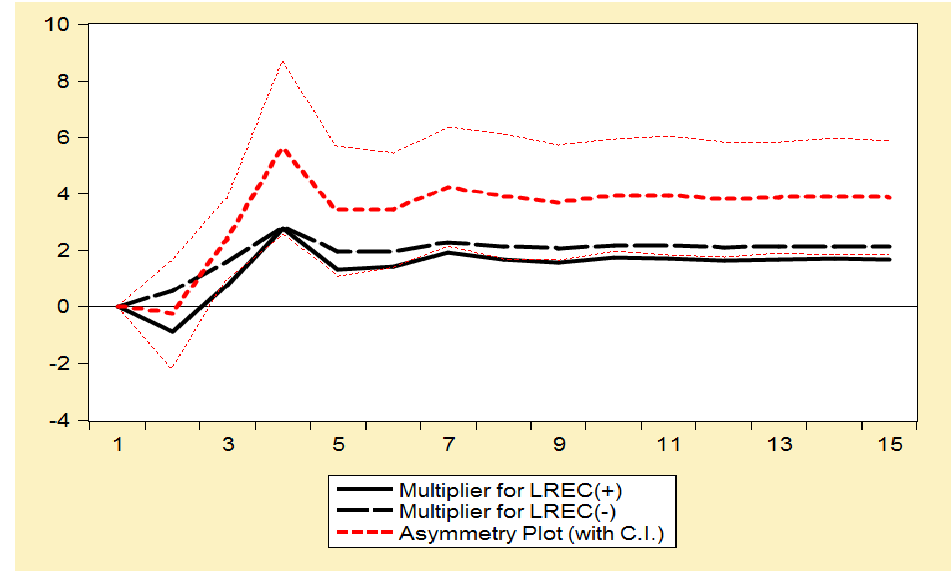
Figure 5. Dynamic Multiplier graph for LREC.